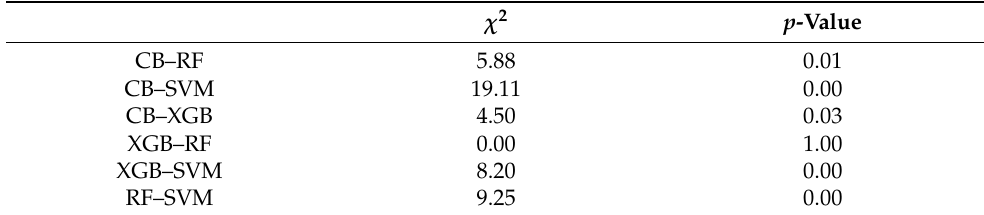
Table 4. Model performance comparison using McNemar’s